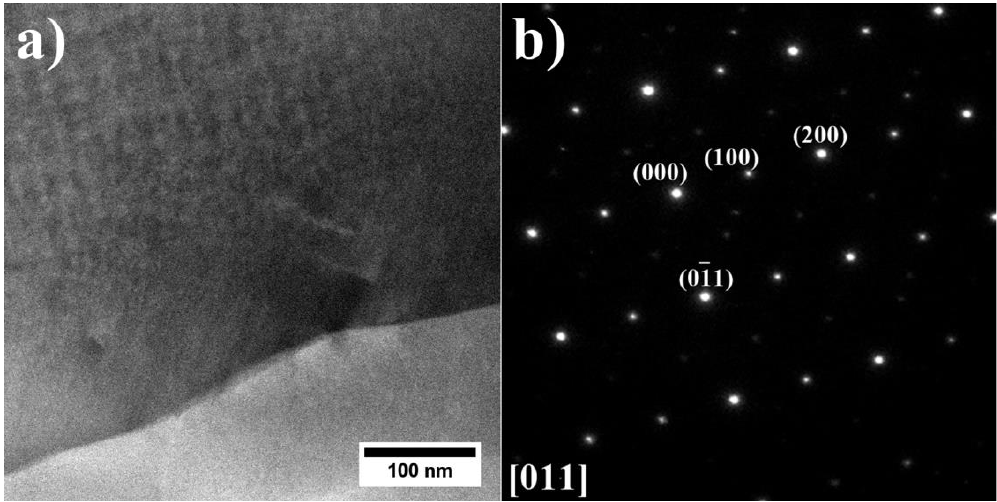
Figure 16. ( a ) Morphology of the β -NiAl phase island (dark part) in the interdendritic space of the superalloy A9; ( b ) corresponding SAED pattern, STEM-HAADF.